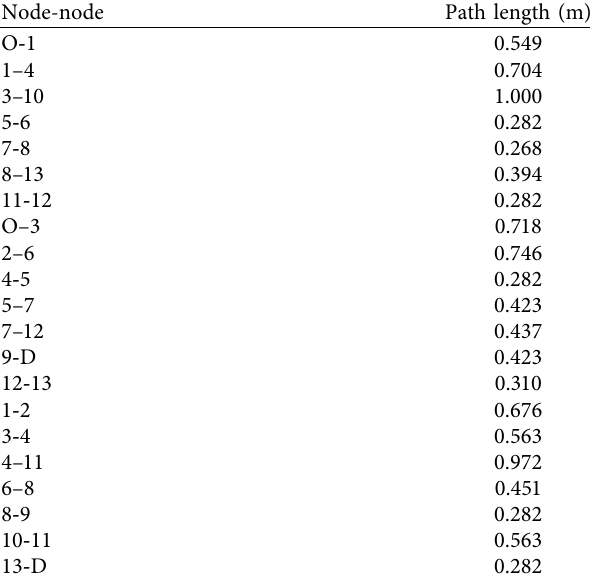
Figure 3: Road network diagram. Table 5: Table of path